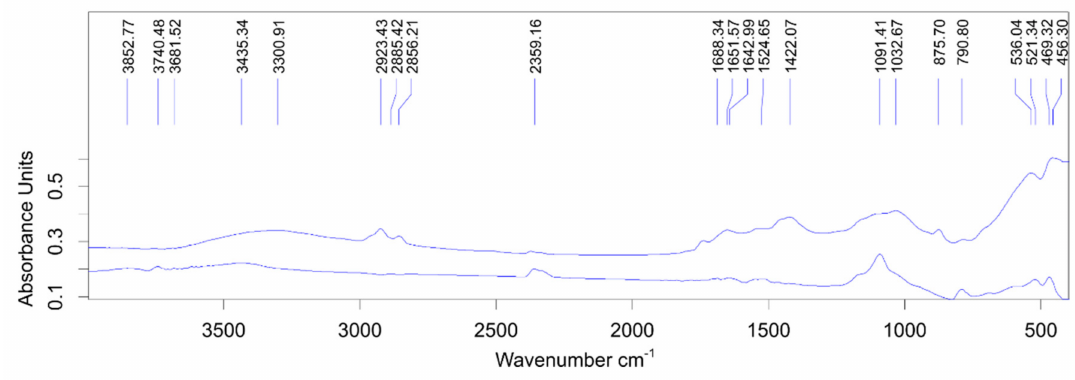
Figure 12. Infrared absorption spectra of manganese ore deposits: Bogach (upper), Zhaksy